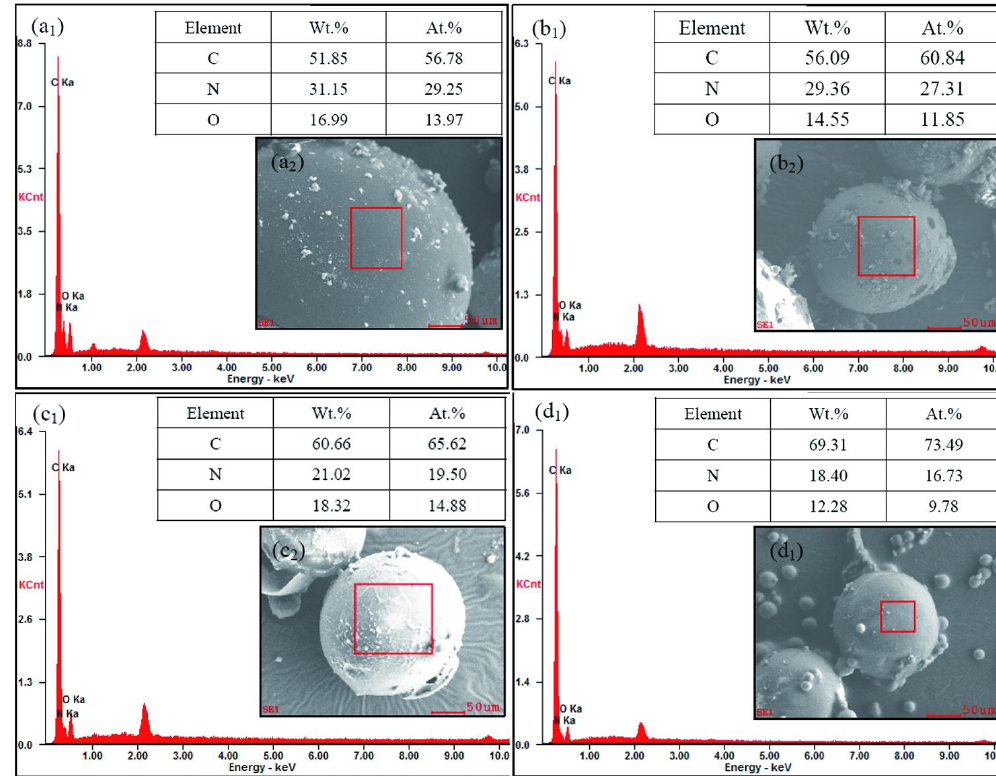
Figure 7. EDS analysis of the self-healing microcapsules without/with graphene, ( a 1 – d 1 ) EDS values of MG-2, MG-4, MG-6 and MG-8; ( a 2 – d 2 ) SEM morphologies of testing points of MG-2, MG-4, MG-6 and MG-8.